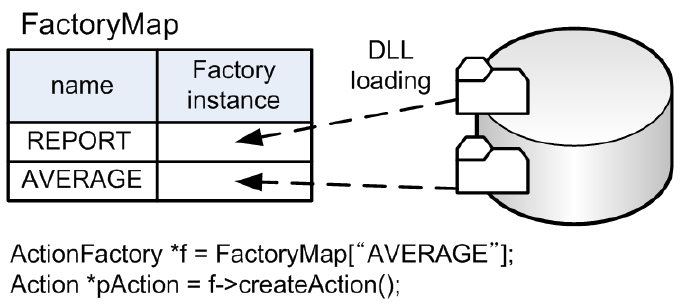
Figure 10. Dynamic action loading with the Abstract Factory pattern and the C++ dynamic